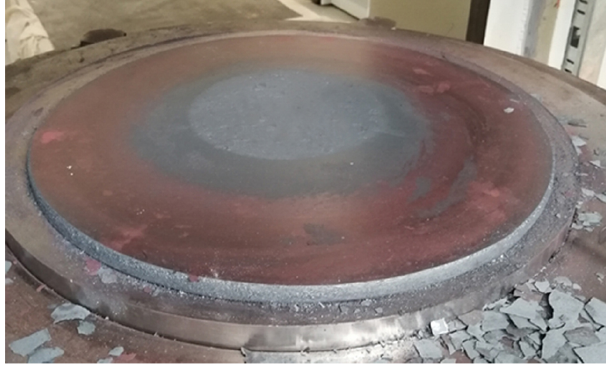
Figure 17. Discs formed on the 500t rotary forging press with dou- ble symmetry rolls.